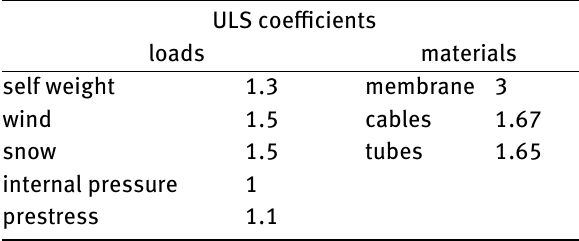
Table 1: ULS coeflcients used in the